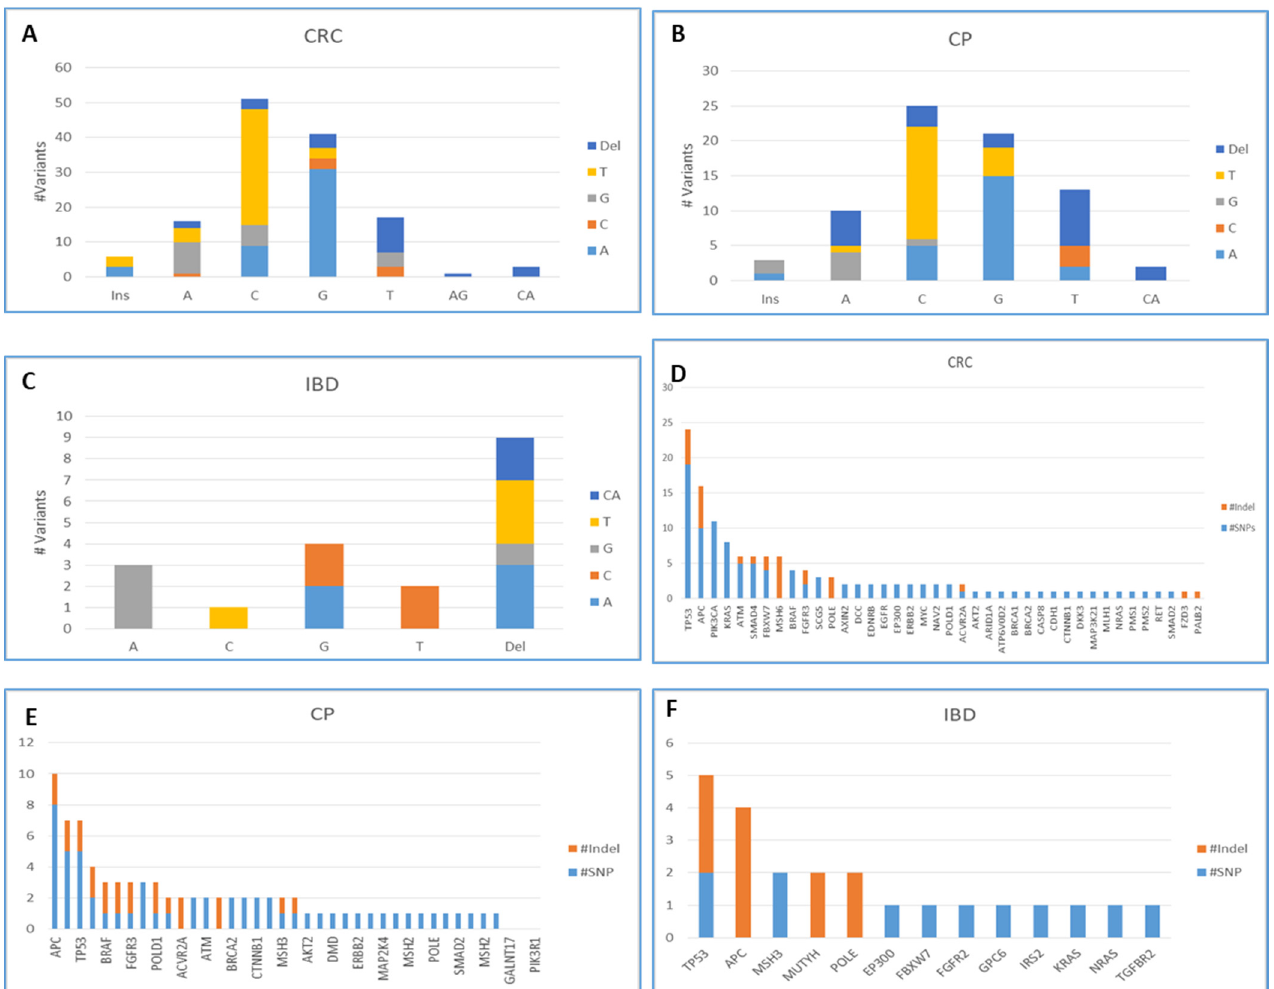
Figure 2. Bar charts ( A – C ) show the changes in the reference alleles to the alternative ones in each studied group. Charts ( D – F ) show the counts of SNPs and Indels in each mutated gene in each studied group.